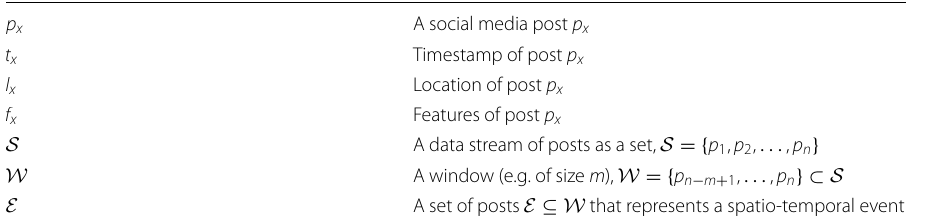
Table 1 High level